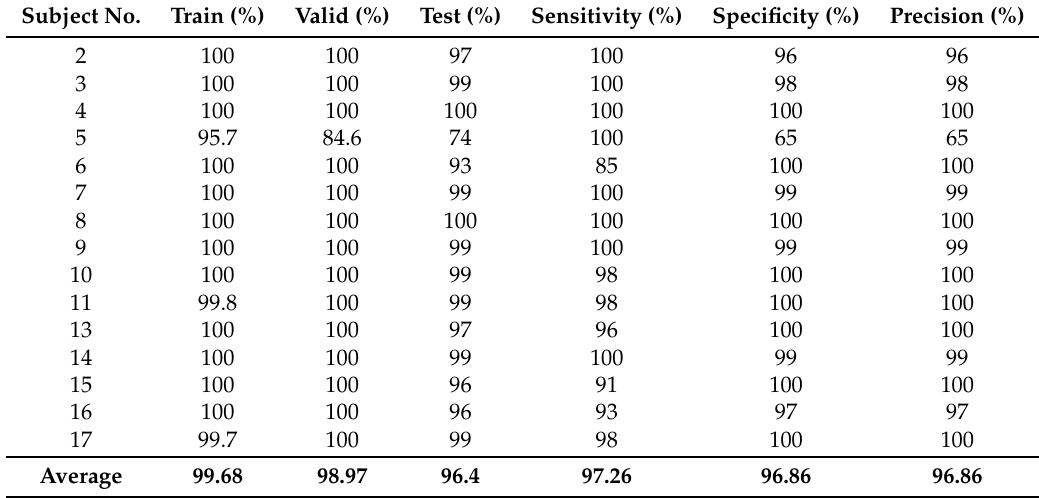
Table 5. The accuracy measures for the person-specific models using frequency domain images.